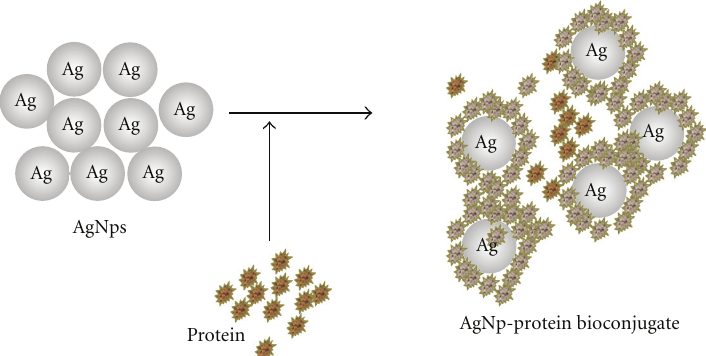
Figure 6: Schematic showing interaction of silver nanoparticles (AgNps) with protein leading to the formation of protein encapsulated